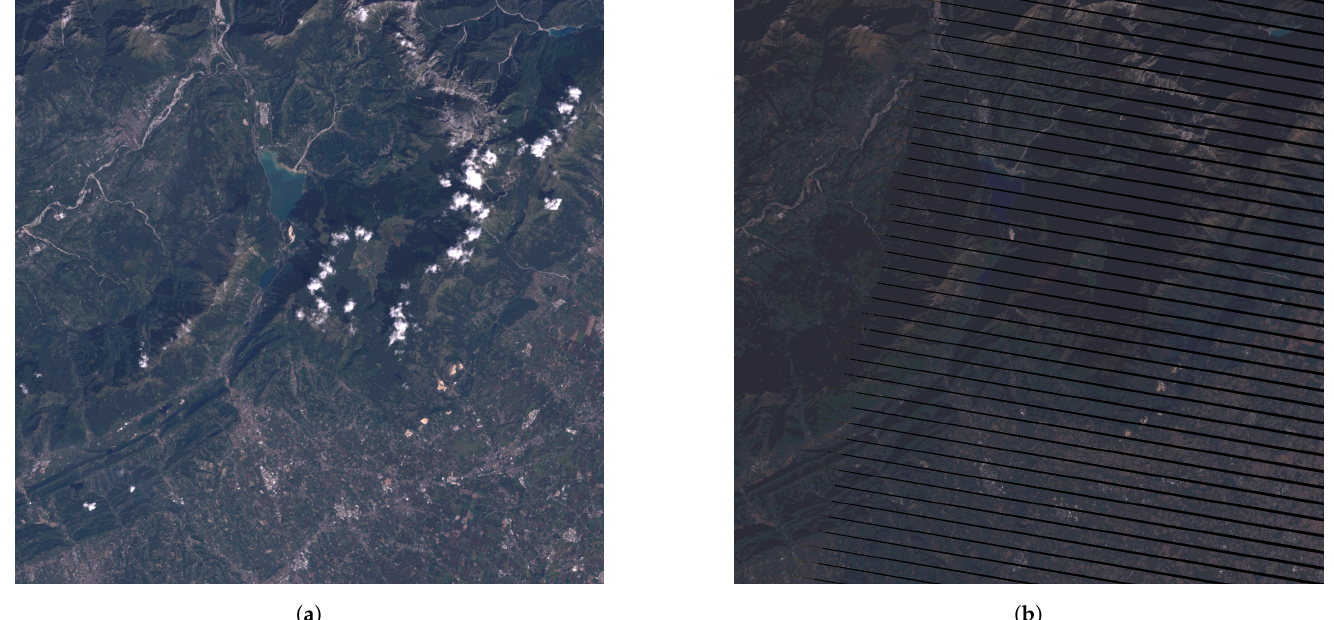
Figure 16. Base and target images from LE71920282002257EDC00 and LE71920282014306NSG100 Landsat 7 scenes. ( a ) base image; ( b ) target